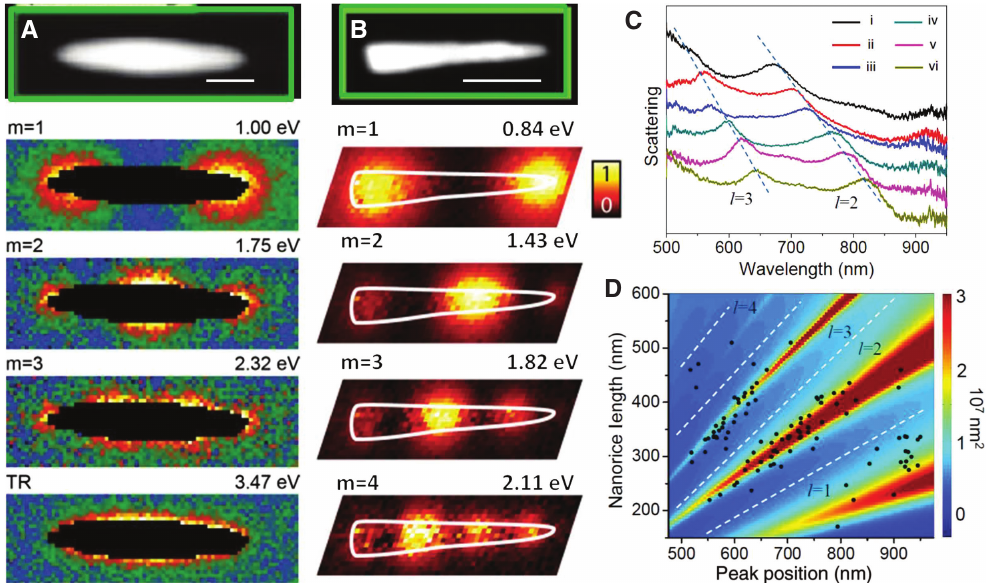
Figure 2: (A, B) High-order plasmon resonances in nanorice (top, 304 nm long and 64 nm diameter at the center) [29] and nanocarrot (top, 225 nm long and 27 nm diameter at the thicker end) [25] were mapped by selectively filtering the scattering intensity belonging to each peak in the EELS signals. Both scale bars are 100 nm. (C) Nonpolarized dark-field scattering spectra of nanorices of various lengths: 300, 328, 335, 363, 417, 436 nm for curves i–vi, respectively [30]. The width of all these nanorices is about 60 nm at the center. The dash lines are eye guides showing the red shift of the plasmon resonances with the increase in the nanorice length. (D) Depend- ence of LSPR peak positions on nanorice lengths [30]. Black dots: Peak positions of different resonance orders for nanorice particles of different lengths determined from dark-field scattering spectra. Four distinct bands separated by the white dashed lines are apparent, corresponding to four well-defined modes with the order indicated by the value of l . Background: Extinction cross-section of individual = 1.2585. Incident direction and nanorice (width of 60 nm) calculated from simulations assuming an effective dielectric surrounding, n eff polarization are both aligned 45 ° with respect to the symmetry axis of the nanorice. Reproduced with permission from Refs. [25, 29, 30]. Copyright 2012 American Chemical Society (Ref. [29]), Copyright 2013 American Chemical Society (Ref. [25]), and Copyright 2010 American Chemical Society (Ref.